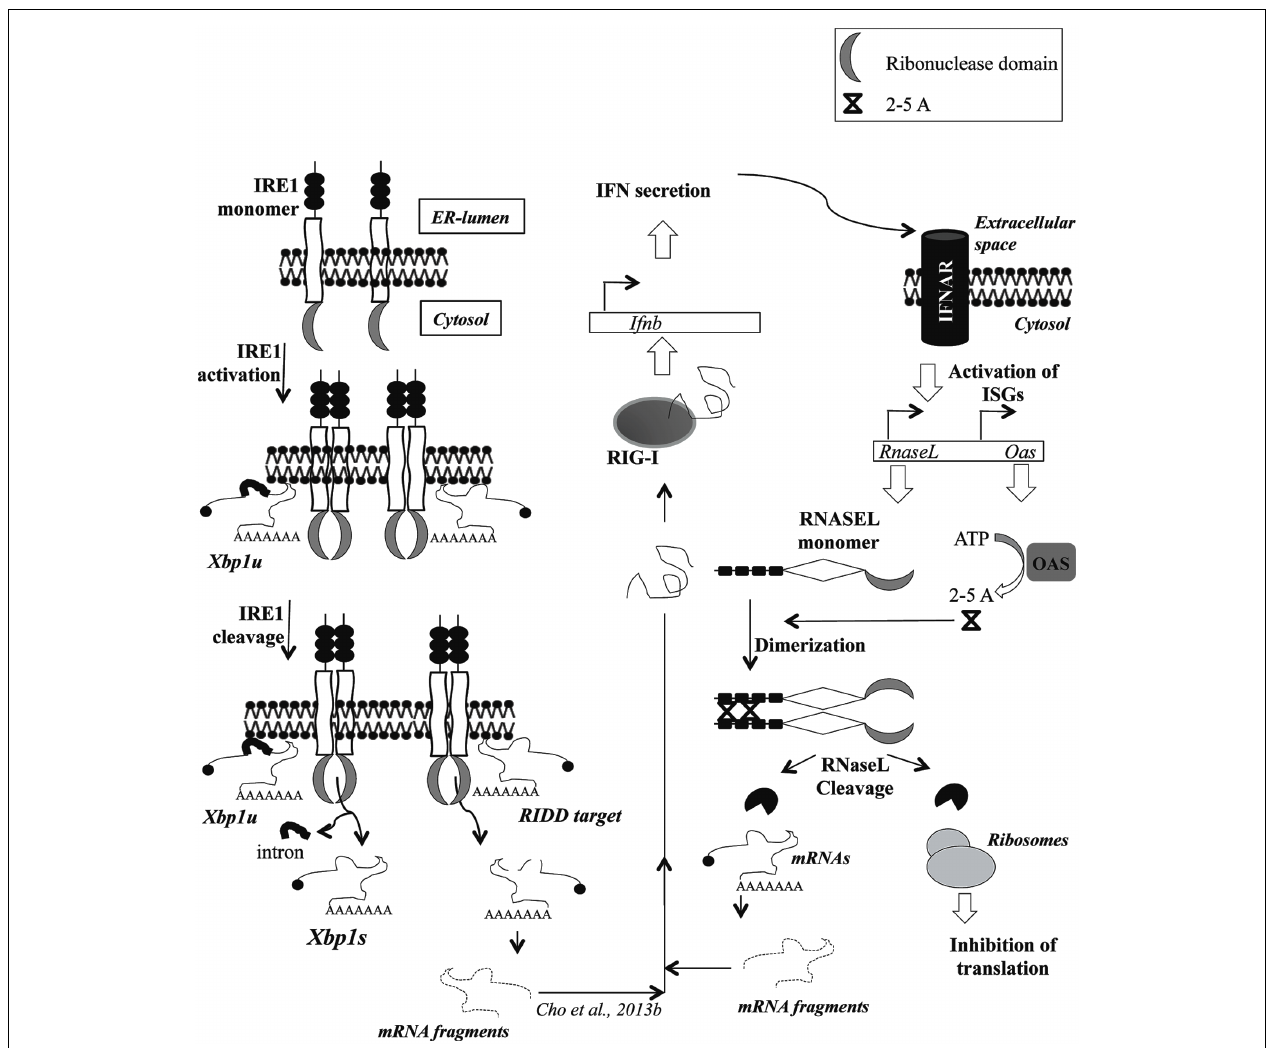
substrates are shown to undergo degradative cleavage. The cleavage products generated through degradation of the respective substrate is shown to potentially interact with RIG-I thereby leading to Interferon secretion and trans-activation of Oas genes through Interferon signaling. Abbreviations: RIG-I = retinoic acid inducible gene-I, Ifnb = interferon beta gene loci, IFN = interferons, ISG = interferon-sensitive